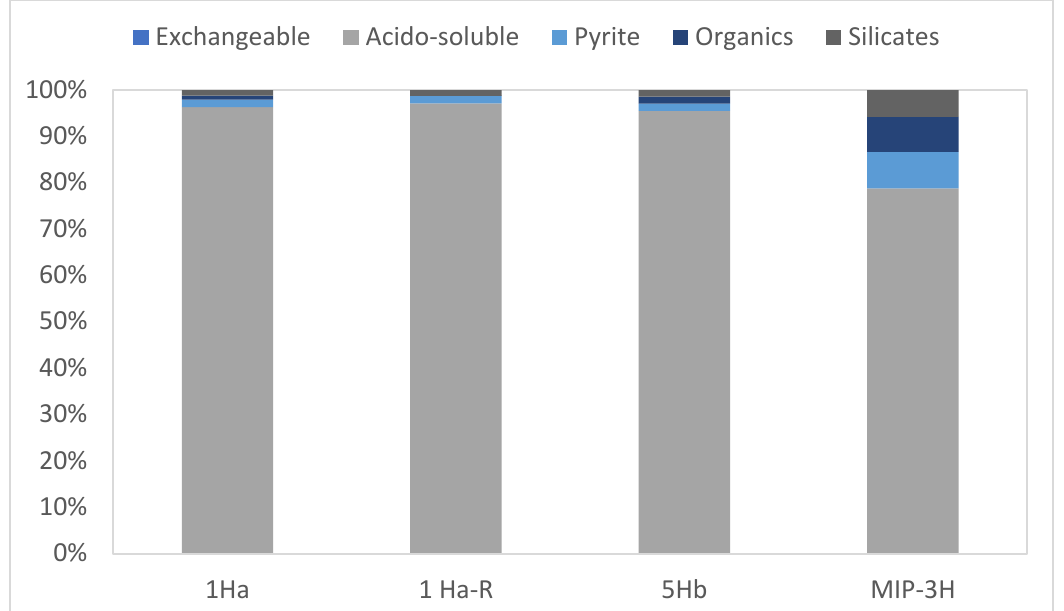
Figure 4. Concentration (in ppm) and percentage of LREE, MREE, and HREE fraction extracted.